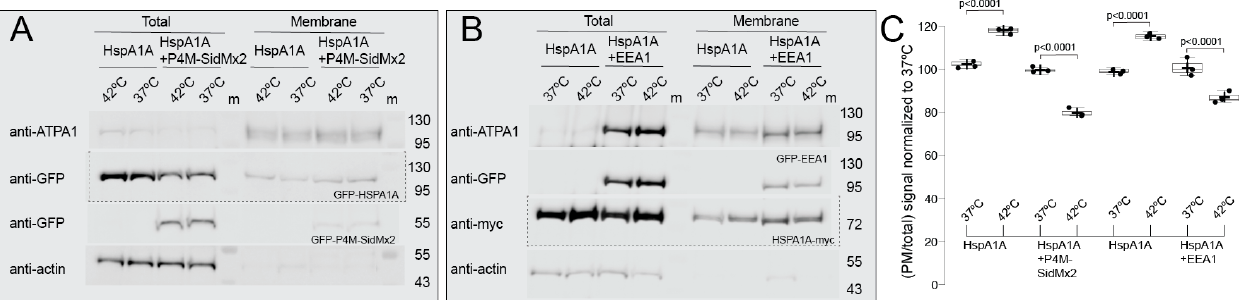
Figure 3. Cell surface biotinylation reveals that HSPA1A’s PM embedding significantly decreases in the presence of biosensors masking PI(4)P and PI(3)P. Representative cropped Western blots showing the total and biotinylated fractions of HEK293 cell lysates transfected with ( A ) GFP-HSPA1A and eGFP (see Supplemental Figure S1 for complete blots), and GFP-HSPA1A and GFP- P4M-SidMx2, ( B ) HSPA1A-myc and eGFP (see Supplemental Figure S1 for complete blots), and HSPA1A-myc and GFP-EEA1. HSPA1A is shown in ( A ) at the anti-GFP panel and in ( B ) at the anti- myc panel. Native actin and ATP1A1 were used a cytosolic and membrane controls, respectively.